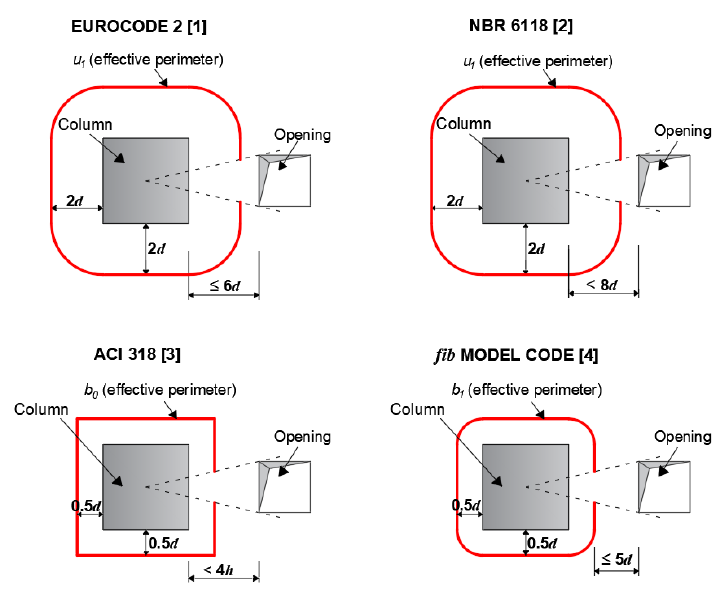
Figure 2. Effective control